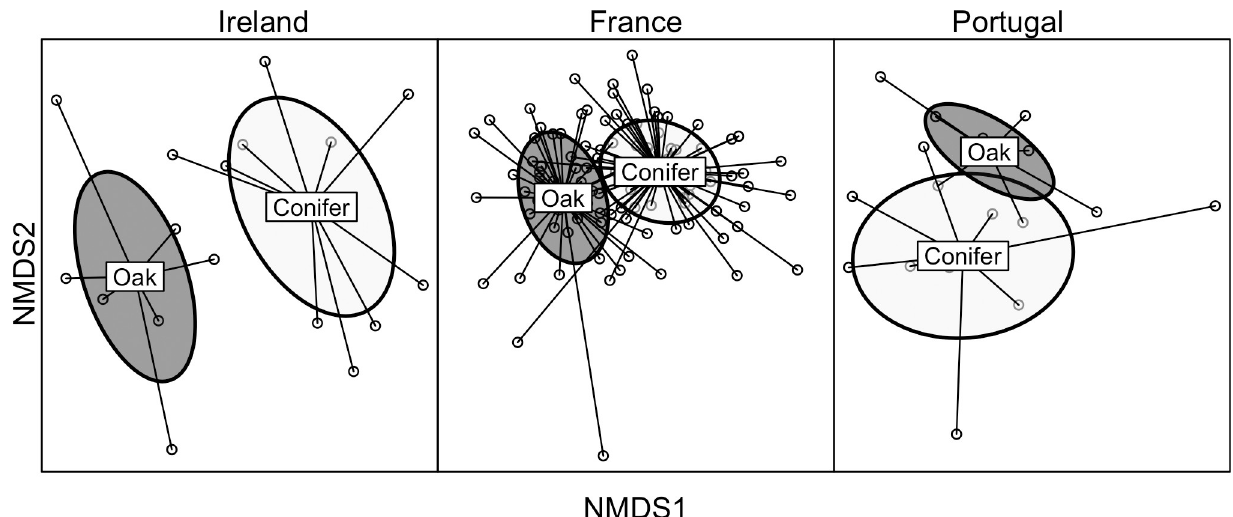
Fig 1. Non-Metric Multidimensional Scaling (NMDS) ordination comparing bird assemblage composition among semi-natural oak forests and conifer plantations in Ireland, France and Portugal (stress scores: Ireland = 0.197, France = 0.222, Portugal = 0.161). Points are forest patches with lines connecting to forest-type centroids. Ellipses represent the standard deviation of forest-type